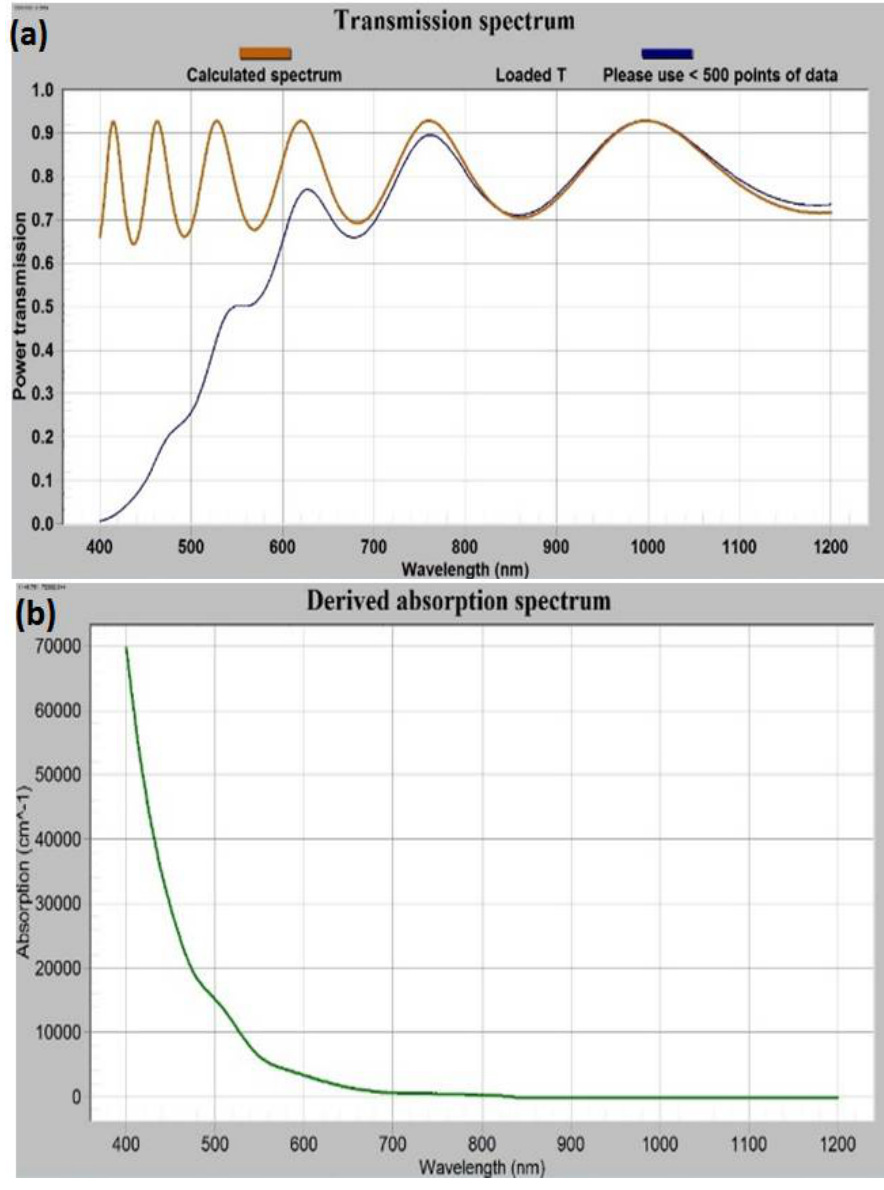
Figure 9. Iterative software-assisted fitting of modelled and measured transmission spectra ( a ), and ( b ) the derived absorption coefficient (α) of an as-deposited garnet sample grown on glass substrate from batch-1. ( b ) the derived absorption coefficient ( α ) of an as-deposited garnet sample grown on glass substrate from